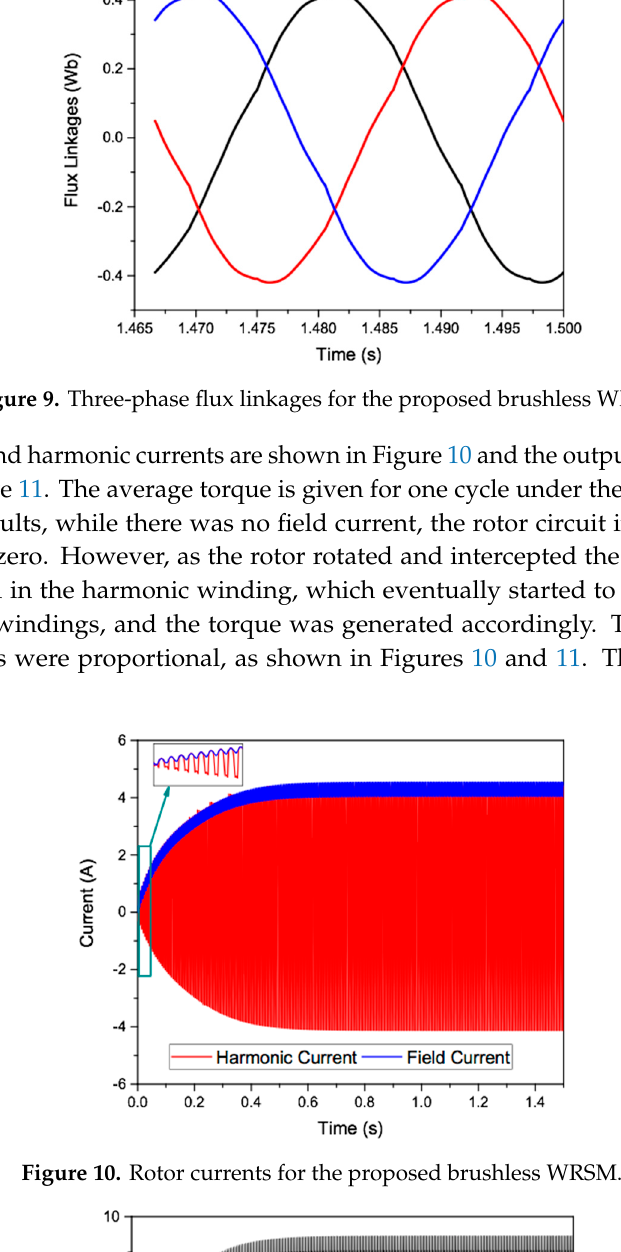
Figure 8. Magnetic flux density distribution plot of the machine at ( a ) 0.015 s and ( b ) 1.5 s.